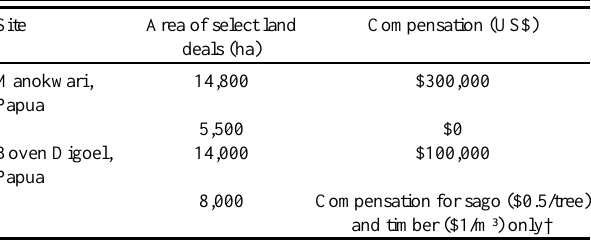
Table 2. Select cases of compensation payments to customary leaders in Papua,